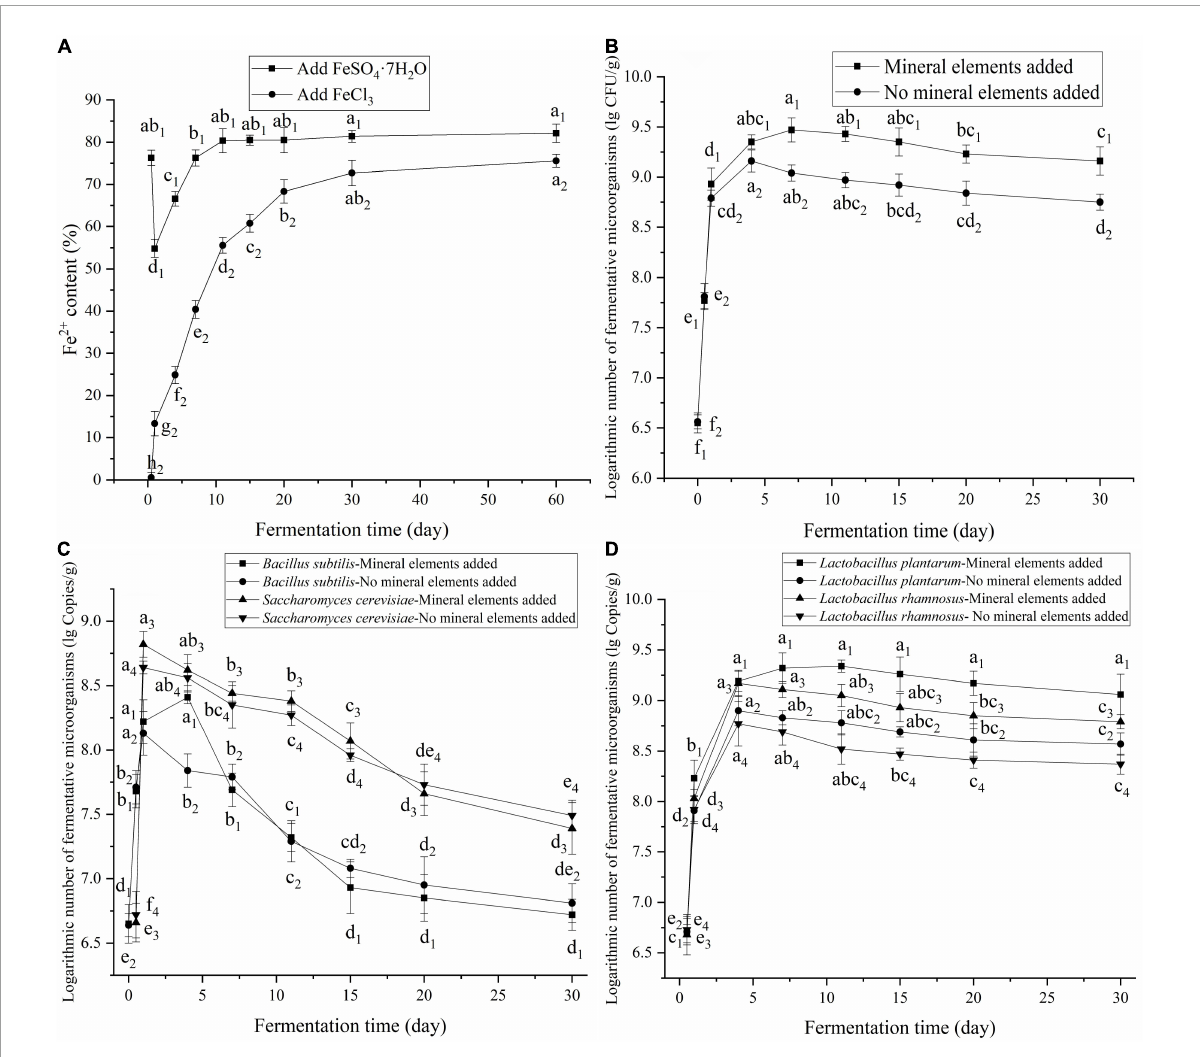
FIGURE5 (A) Effect of fermentation on the redox of Fe 2 + and Fe 3 + ; (B) Effect of mineral elements on the number of viable microorganisms; (C) Effect of mineral elements on the growth of Bacillus subtilis and Saccharomyces cerevisiae ; (D) Effect of mineral elements on the growth of Lactobacillus . Values expressed as mean ± standard deviation ( n =